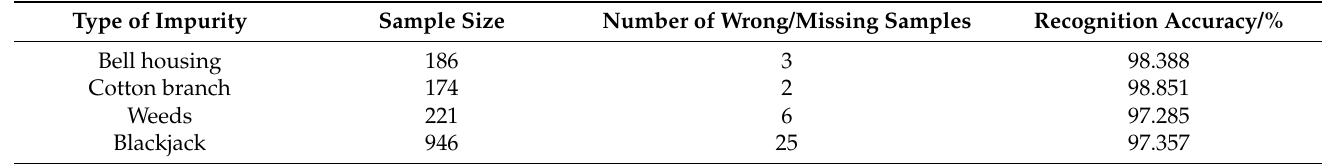
Table 2. Classification and recognition accuracy of various